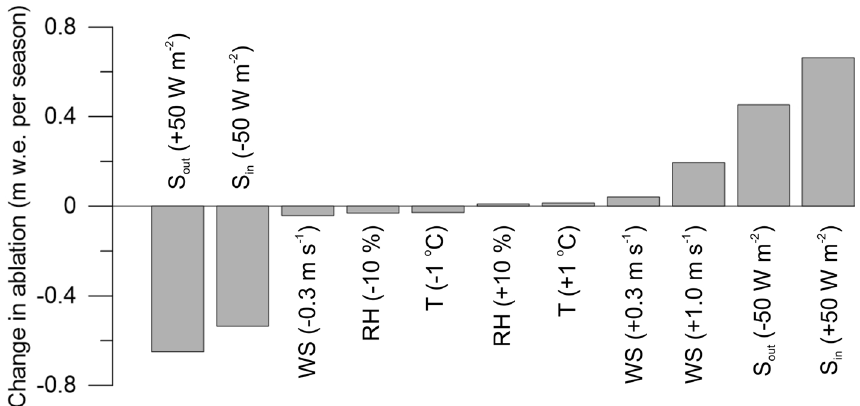
Figure 7. Calculated changes in total ablation for the period 7 July to 23 August (in m w.e.) after perturbations to input parameters: air temperature (T, ± 1 °C), relative humidity (RH, ± 10%), wind speed (WS, ± 0.3 and + 1.0 m s −1 ), and incoming (S in , ± 50 W m −2 ) and reflected (S ref , ± 50 W m −2 ) shortwave